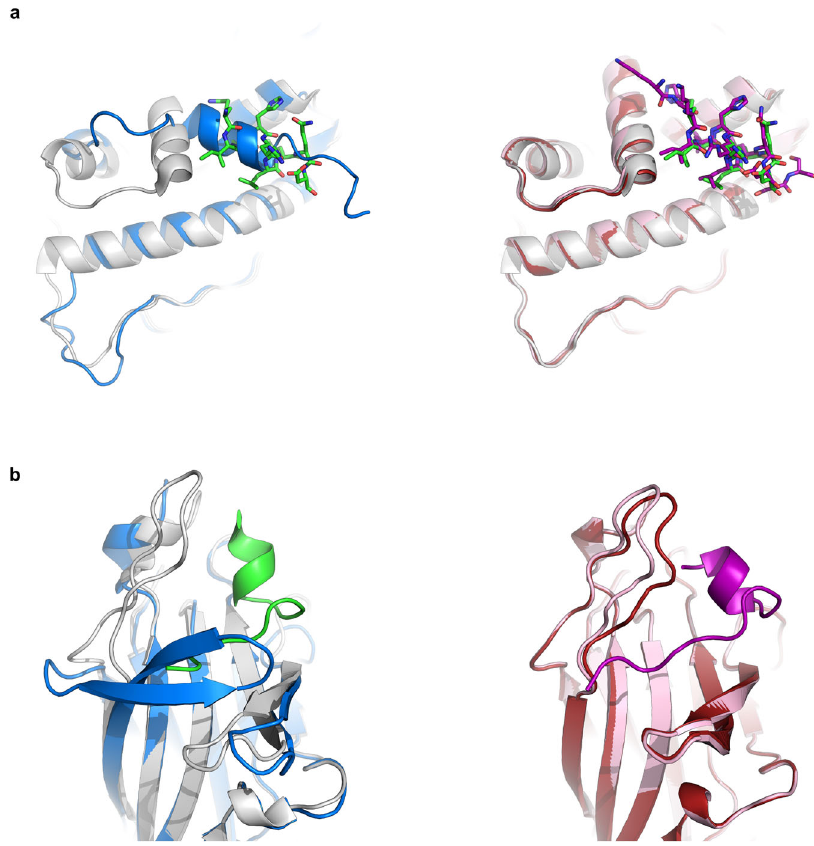
Fig. 4 AF2 modeling of interactions involving signi fi cant changes in receptor conformation. a Estrogen receptor alpha - peptide derived from nuclear receptor cofactor 2 (PDB ID 2b1z 66 ). Left: In the free receptor conformation (PDB ID 3ert 67 ) the C-terminal helix occupies the peptide binding site. Shown are the solved crystal structures of the unbound (blue) and bound conformation (receptor in white, peptide in green). Right: AF2 models the correct receptor conformation, and positions the peptide accurately in the binding site (RMSD< 1.0 Å). Shown are the AF2 model (unbound receptor: maroon, bound receptor: pale pink, peptide: magenta), compared to bound conformation (white). b EphB4 receptor –– ephrin-B2 antagonist (PDB ID 2bba 68 ). Left: In the free receptor conformation (PDB ID 3etp 69 ) the J – K loop forms a β -hairpin. Right: Upon peptide binding, this hairpin becomes disordered and assumes a fl exible loop conformation, which is recovered in the AF2 model. Coloring as in a